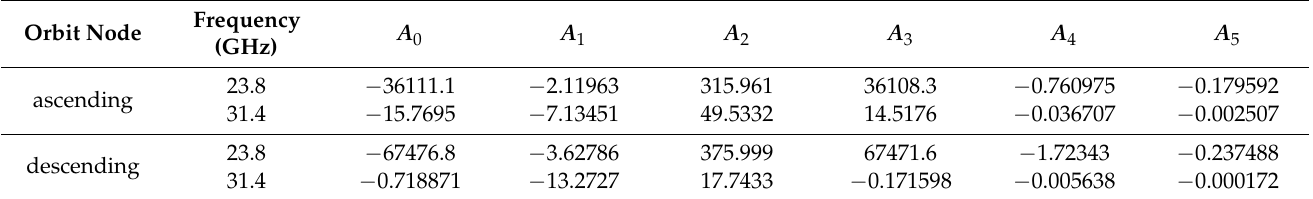
Table 4. Coefficients used to correct FY-3E MWTS-III cross-track